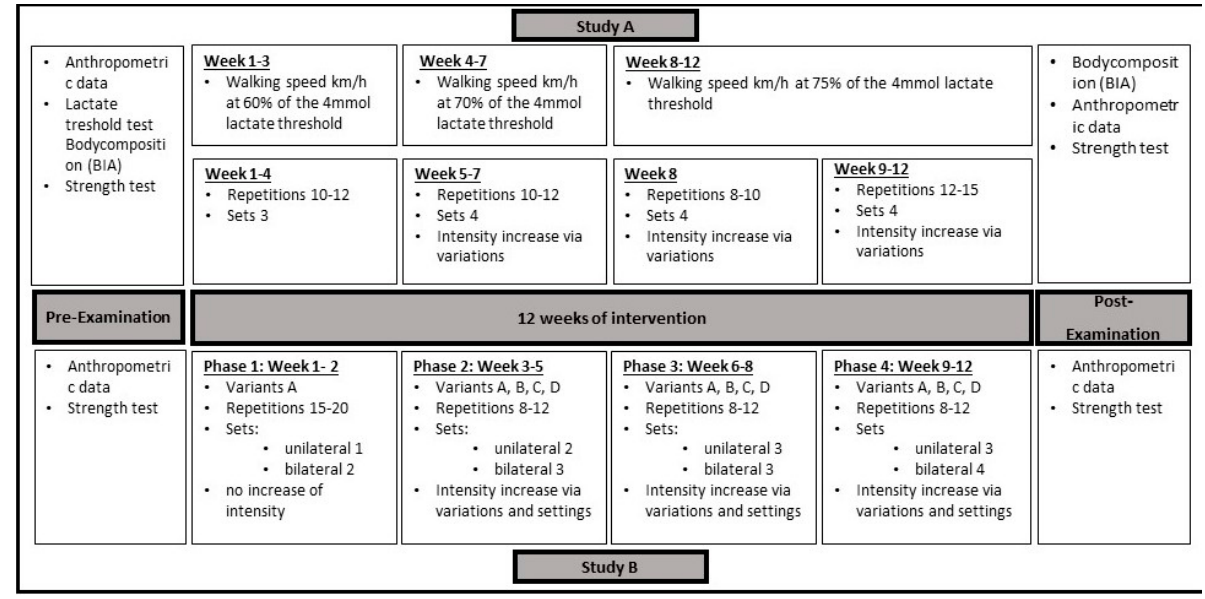
Figure 2. Study A and B protocols. Variants A–D describe the increase in di ffi culty by reducing the support base in each exercise variation.